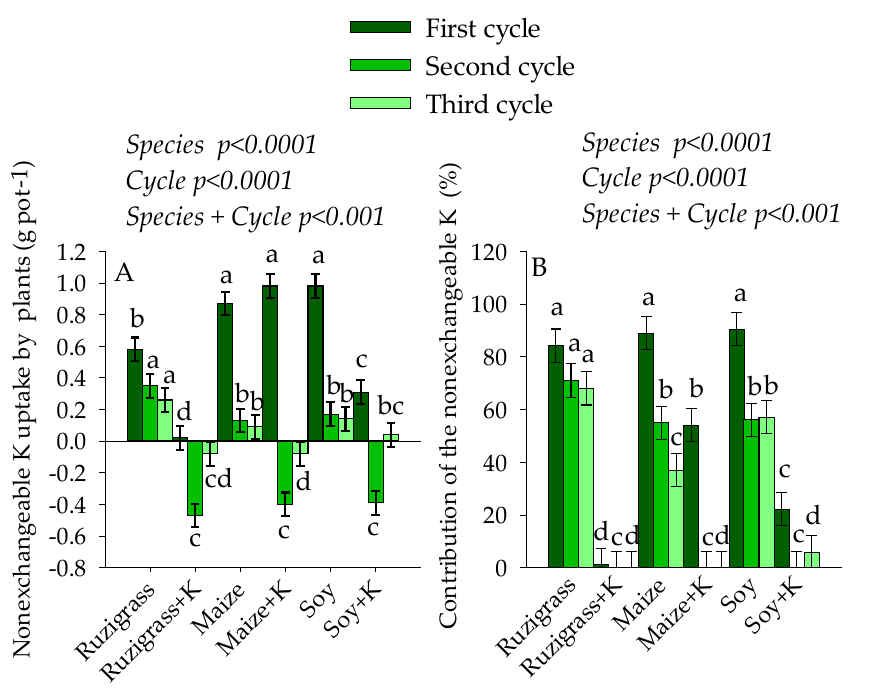
Figure 4. Nonexchangeable K uptake by plants (Kbal-neg) during each crop growth cycle ( A ), and the contribution of nonexchangeable K to total K uptake ( B ). Maize and soybean were grown for 90 days, and ruzigrass was grown for 45 days. The absence of overlap by vertical bars shows significant differences among the cycles, and lowercase letters indicate differences among species within given a fertility treatment and cycle (LSD, p ≤ 0.05). Exchangeable K was extractable by a Na-saturated exchange resin, and non-exchangeable K is the difference between K extracted by boiling 1 M HNO 3 and exchangeable